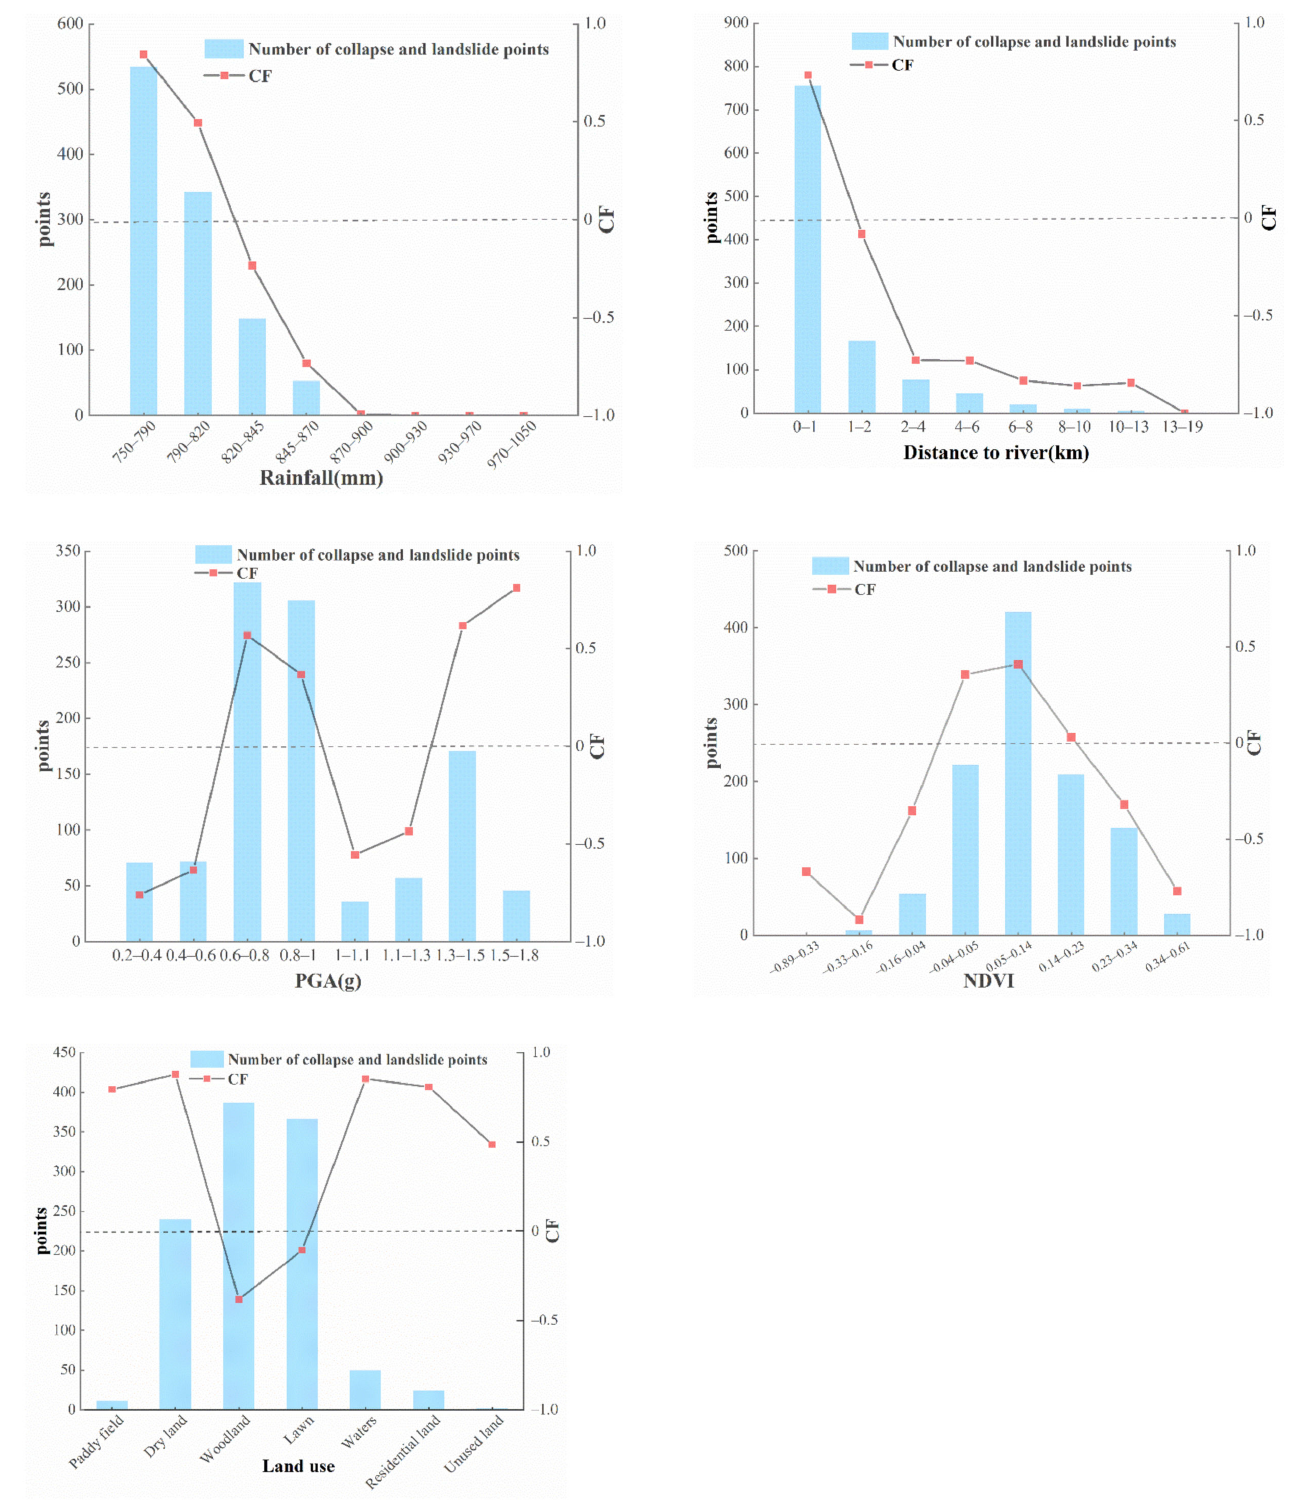
Figure 5. Distribution of the number of collapse and landslide points and the CF value in the attribute interval of environmental